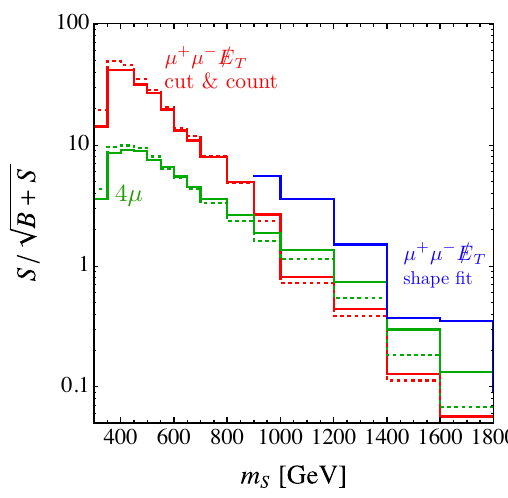
Figure 13: Significance of the mono- Z (cid:48) signal in red in comparison to the 4-muon signal in green for difference scalar masses and for s α = 0.2 ( 0.4 ) shown by the solid (dotted) contours, respectively. The red (blue) contours correspond to the signifi- cance based on the cut & count (shape fit)